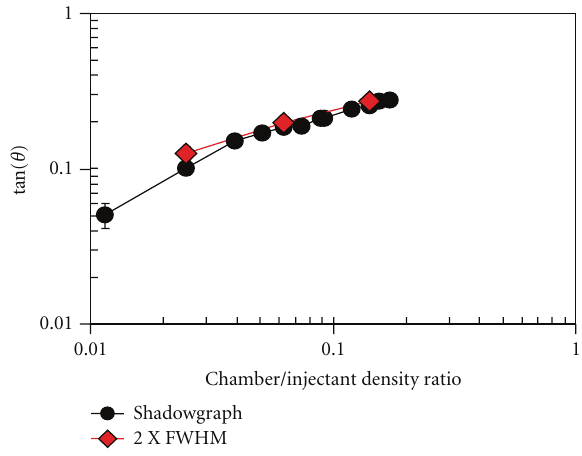
Figure 6: Comparison of the tangent of the spreading angle for a single jet of LN 2 injected into GN 2 measured using shadowgraph and Raman’s techniques at twice the FWHM values. Chehroudi et al. [20].